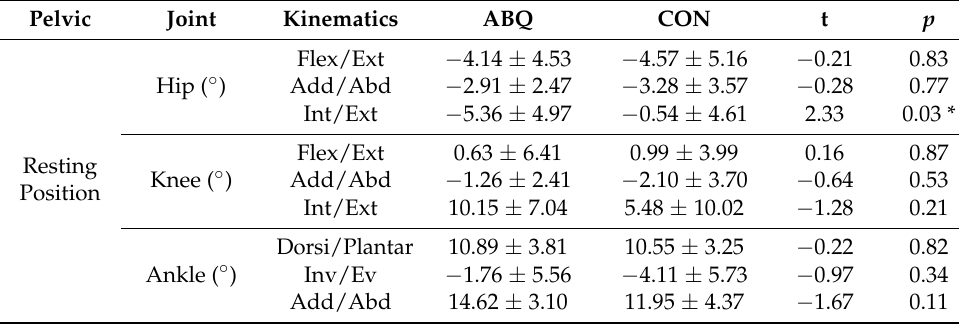
Table 2. Effects of Q-angle on lower-limb kinematic variables in each position.